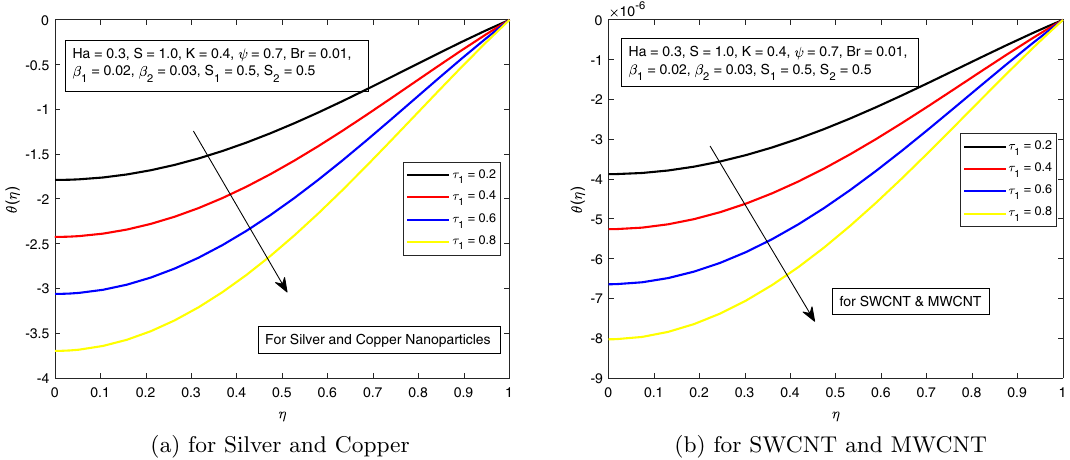
Figure 6. Influence of τ 1 on temperature distribution θ( r ) for the hybrid nanofluid combination of ( a ). Ag and Cu , ( b ) SWCNT and MWCNT .